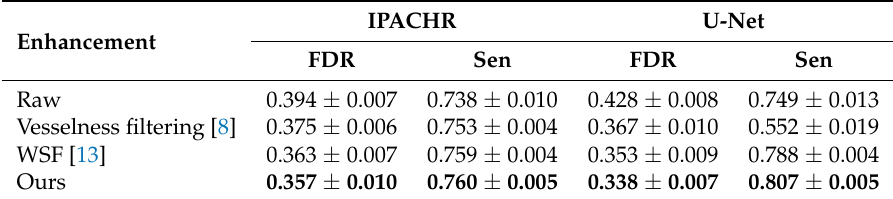
Table 5. Segmentation results of different enhancement methods with IPACHR and U-Net on nerve fiber images.